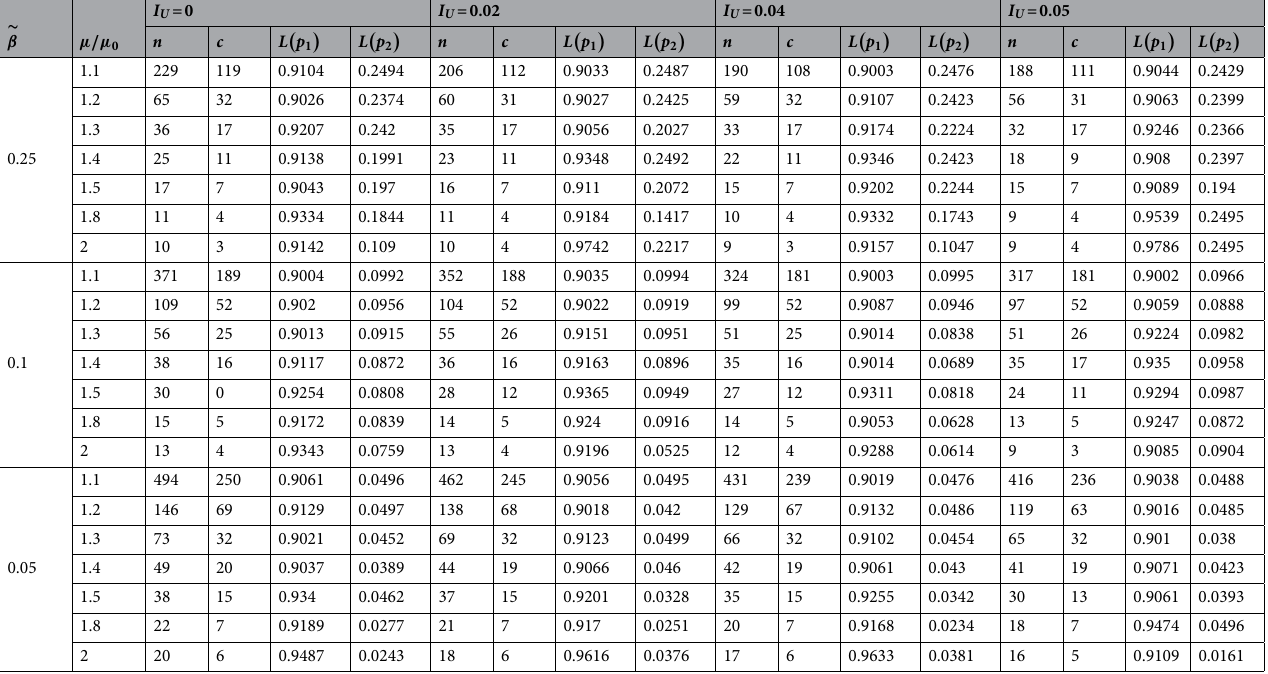
∼ α = 0.10 ; β = 2 and a = 0.10 .